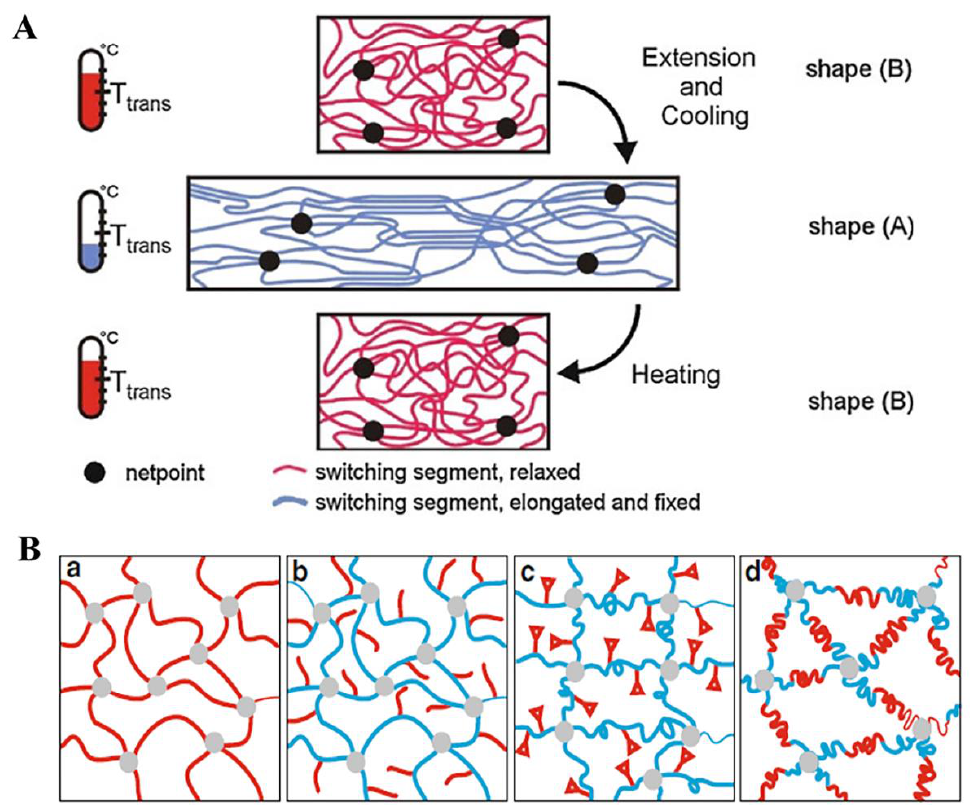
Figure 1. Shape memory effect of polymeric materials. ( A ) Thermal programming of shape memory effect (SME) [24] and ( B ) Polymer network showing SME (red = molecular switches and gray = netpoints): switching segments linking netpoints ( a ), side chains as switching segments ( b ), molecular switches forming covalent bond reversibly ( c ), ABA triblock segments linking netpoints ( d ) [21]. Reprinted with permission from [21,24]. T trans = thermal transition temperature of the switching.